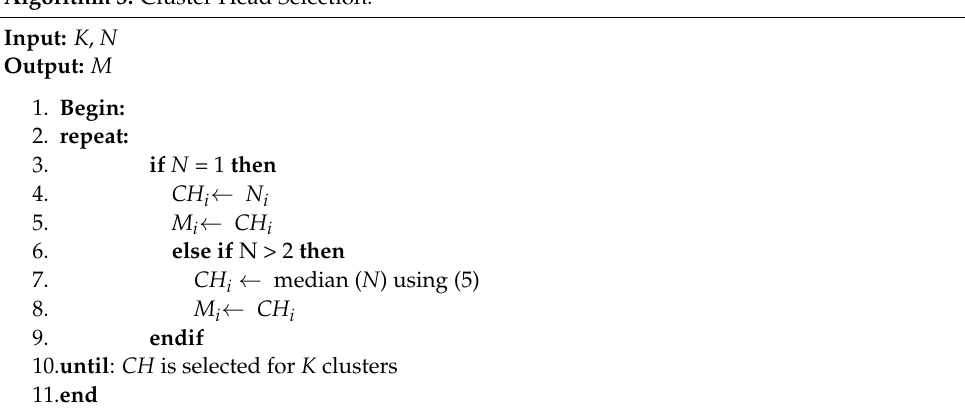
Algorithm 3: Cluster Head